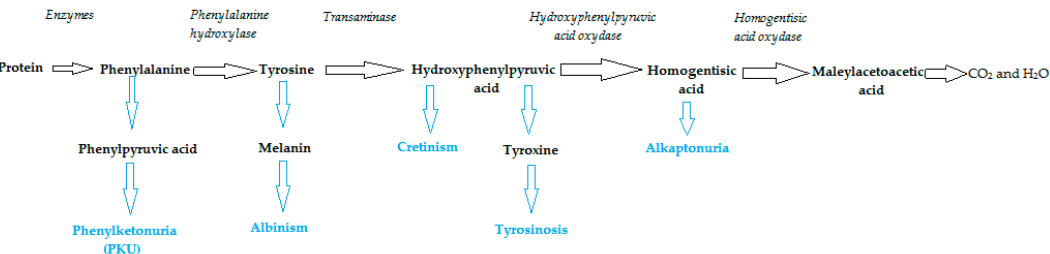
Figure 4. Phe transformation into tyrosine and its metabolism [17] .